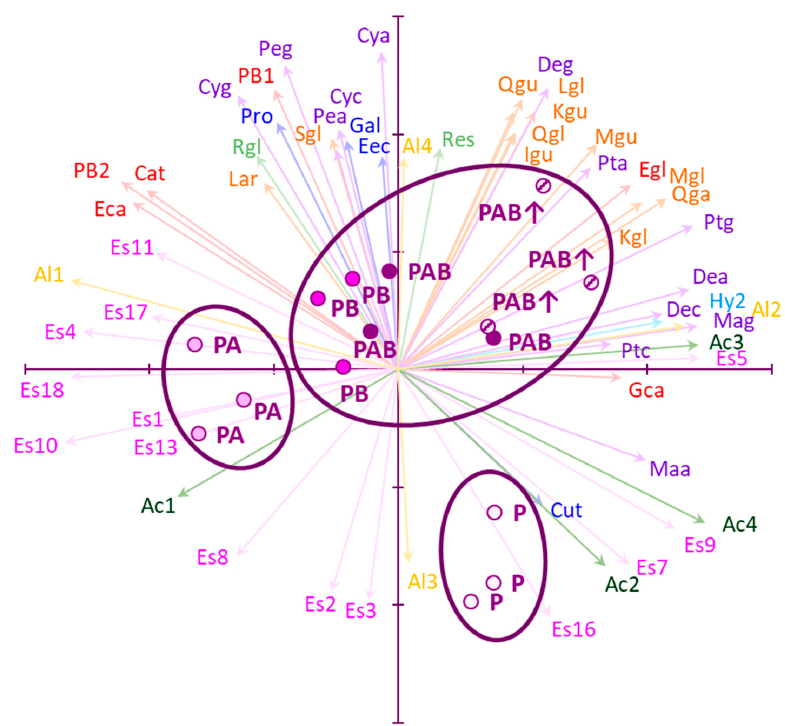
Figure 3. Ordination, through principal components analysis (PCA), of wines made from grapes exposed to five different radiation regimes: P (only PAR), PA (PAR + UV-A), PB (PAR + UV-B), PAB (PAR + UV-A + UV-B), and PAB ↑ (PAR + UV-A + enhanced UV-B). PCA was based on the content of individual phenolic compounds and volatile organic compounds (VOCs). Biological replicates of treatments were used for ordination. Significant loading factors are shown as arrows. Ac1, ethanoic acid; Ac2, hexanoic acid; Ac3, nonanoic acid; Ac4, octanoic acid; Al1, 3-methyl butanol; Al2, 2-methyl- 1-butanol; Al3, 1-hexanol; Al4, phenyl ethyl alcohol; Cat, catechin; Cut, coumaroyl tartaric acid; Cya, cyanidin-(6 (cid:48) -acetyl)glucoside; Cyc, cyanidin-(6 (cid:48) -p-coumaroyl)glucoside; Cyg, cyanidin-glucoside; Dea, delphinidin-(6 (cid:48) -acetyl)glucoside; Dec, delphinidin-(6 (cid:48) -p-coumaroyl)glucoside; Deg, delphinidin- glucoside; Eca, epicatechin; Eec, caffeic acid ethyl ester; Egl, epigallocatechin; Es1, ethyl butanoate;